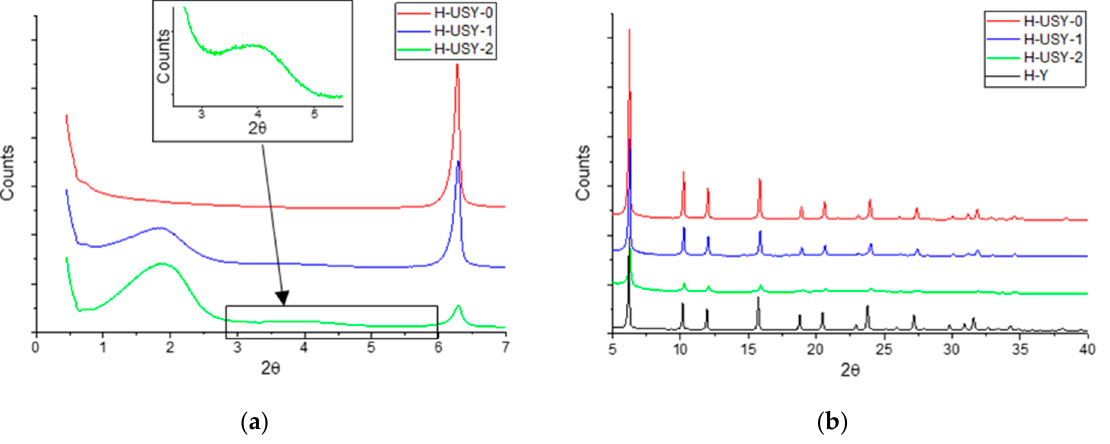
Figure 3. (a ) Small angles XRD patterns. ( b ) Wide angles XRD patterns. Figure 3. ( a ) Small angles XRD patterns. ( b ) Wide angles XRD Table 2. Unit cell parameter, framework Si/Al ratio, and crystallinity obtained from XRD measure- ments.